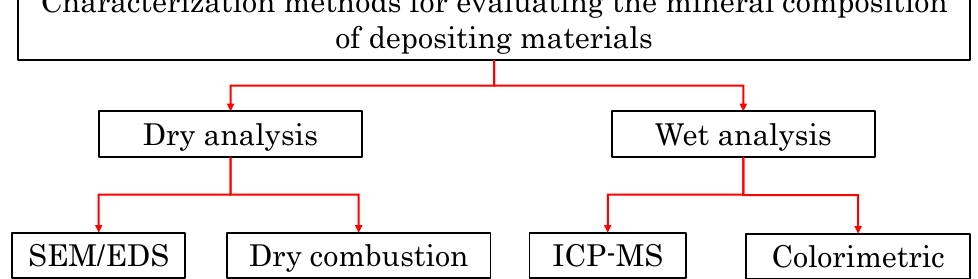
Figure 2. Characterization methods used to evaluate the mineral composition of materials deposited on the surfaces of the completion